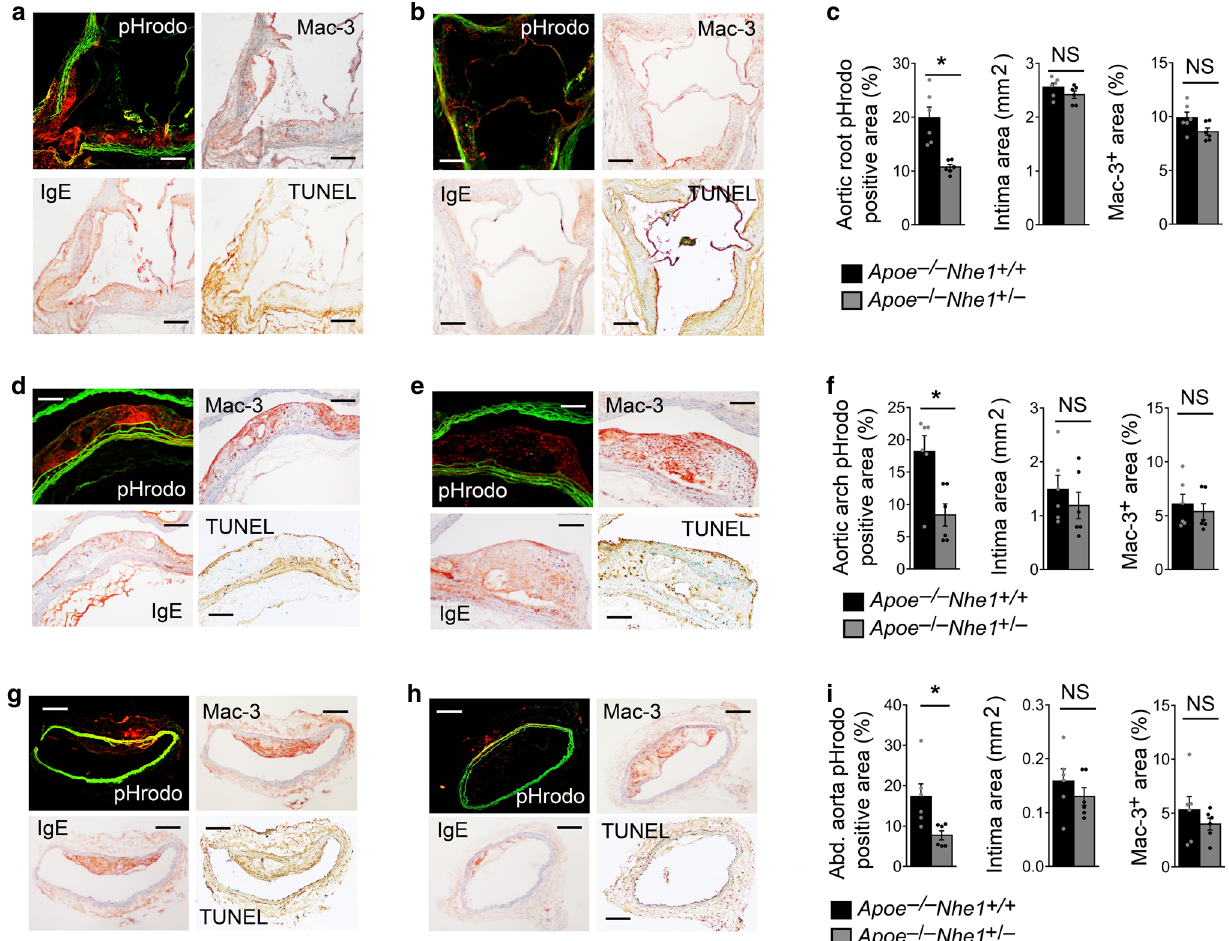
Fig. 3 NHE1-de fi ceincy reduces atherosclerotic lesion acidi fi cation. pHrodo-positive acidic area, Mac-3-positive macrophages, IgE expression, and TUNEL- positive apoptotic cells are colocalized in atherosclerotic lesions from aortic roots a – c , aortic arches d – f , and abdominal aortas g – i from both Apoe – / – Nhe1 + / + control mice a , d , g and Apoe – / – Nhe1 + / – mice b , e , h . Bars: 200 µ m. Sections with comparable lesion size and Mac-3-positive macrophage contents from Apoe – / – Nhe1 + / + control mice and Apoe – / – Nhe1 + / – mice are selected and quanti fi ed as shown in the right two panels from panels c , f , and i . Data are mean ± SEM. n = 6 per group.Two-tailed Student ’ s t- test (three panels in c , middle panel in f , middle and right panels in i ) and Mann – Whitney U- test (right and left panels in f , left panel in i ) were used for statistic analyses. * P < 0.05. NS: no signi fi cant difference. Source data are provided as a Source Data fi